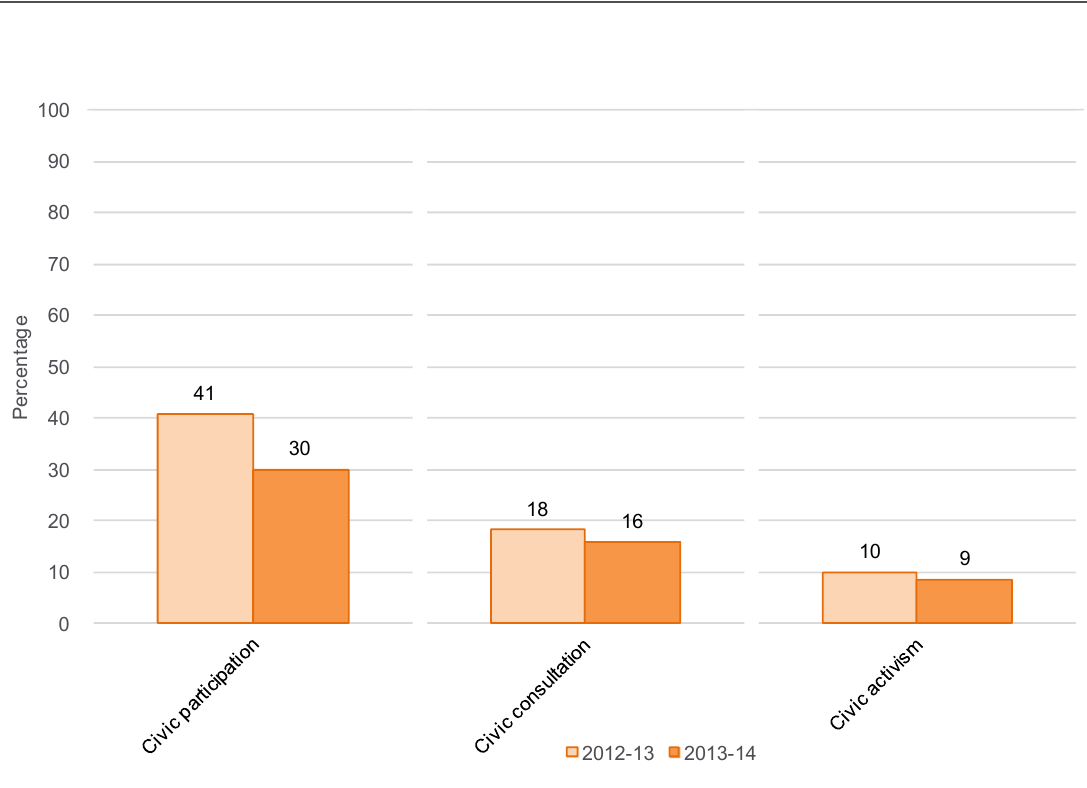
- Table 1: Participation in civic engagement and voluntary activities, 2001 to 2013-14 - Table 2: Participation in civic engagement and formal volunteering at least once in the last year, by sex, age, ethnicity and disability, 2007-08 to 2013-14